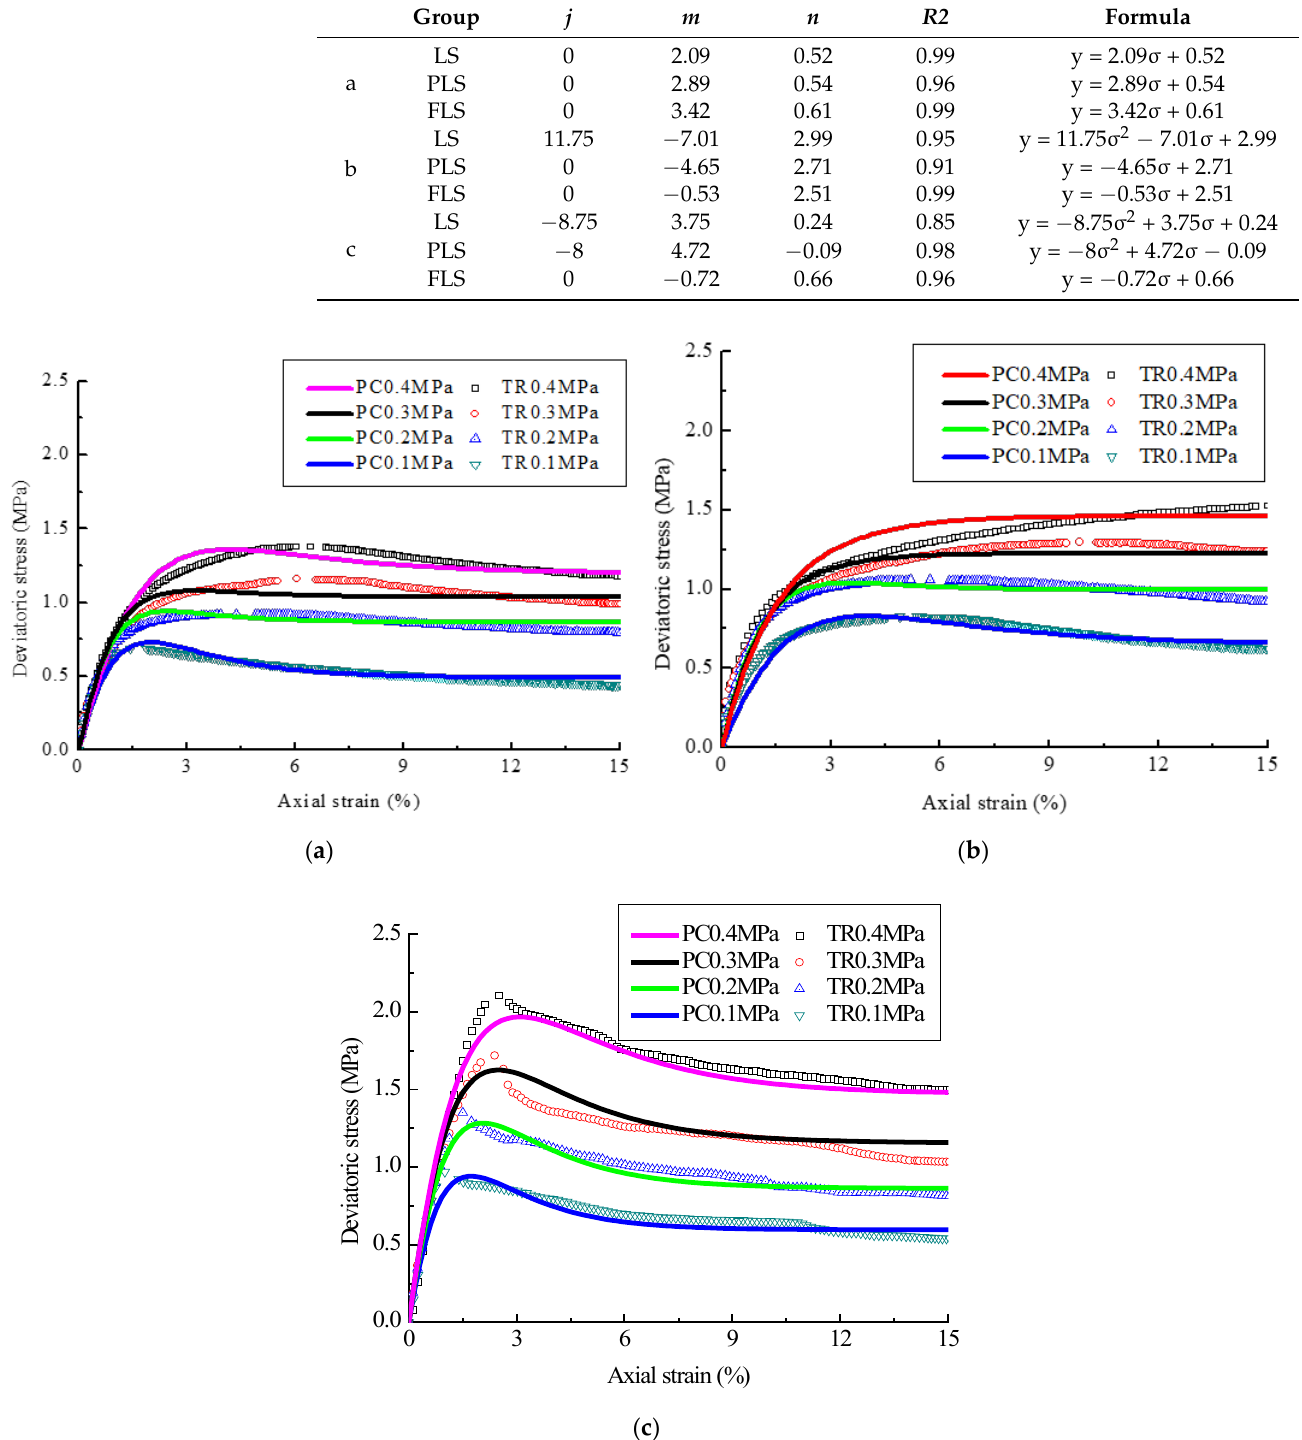
Table 8. Fitting parameters and formulas.